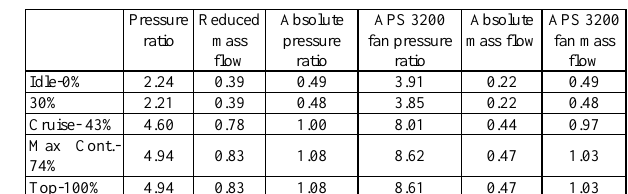
Table 20. Parameter of APS 3200 V = 0.2 Ma, H = 7000